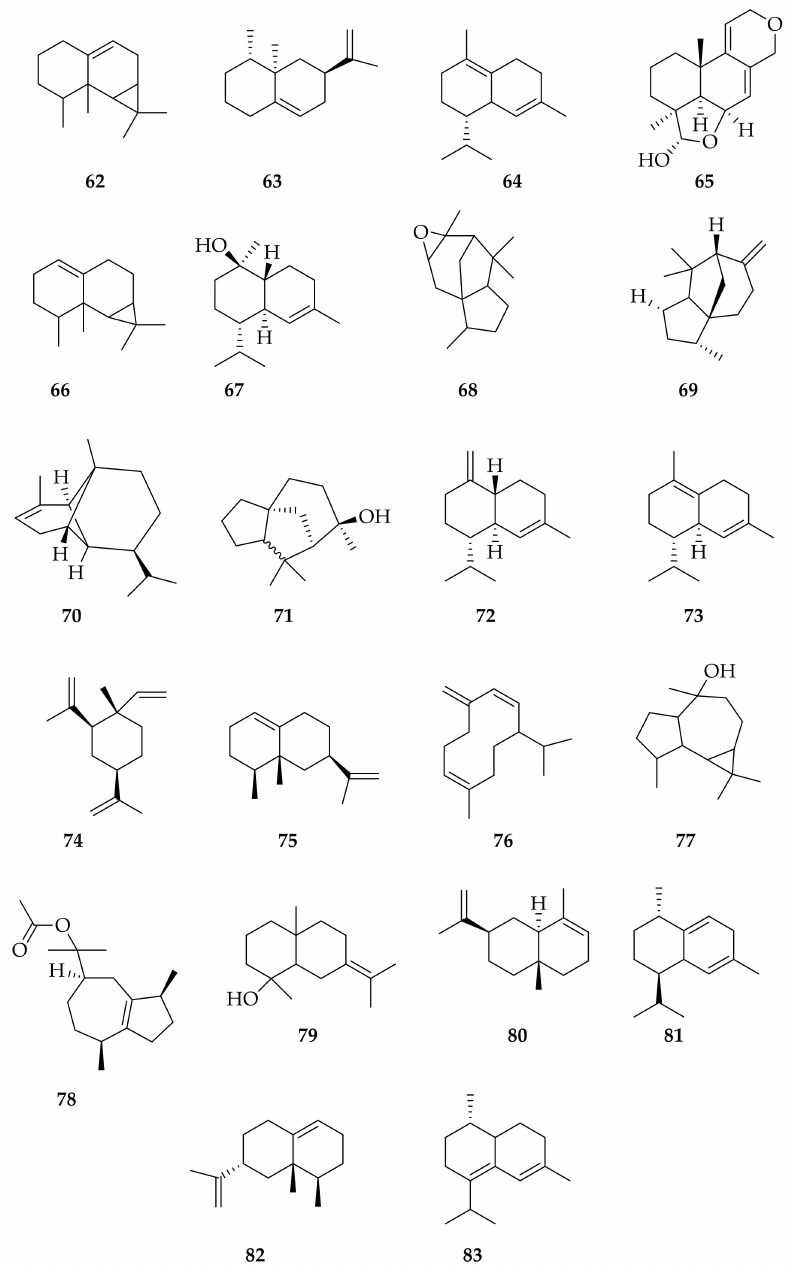
Figure 9. Structures sesquiterpenes: aristolene, aristolochene, δ -amorphene, botryosterpene, calarene, α -cadinol, α -cedrene epoxide, β -cedren-9-one, α -copaene, 5-neo-cedranol, γ -cadinene, δ -cadinene, β -elemene, ermophylene, germacrene D, globulol, guaiol acetate, juniper camphor, α -selinene, trans - cadina-1(2)-4-diene, valecene, zonarene ( 62 – 83